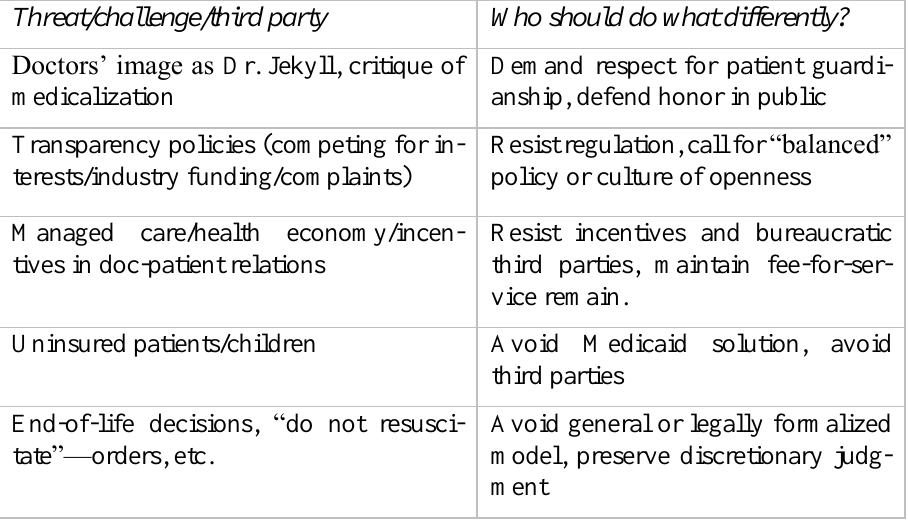
US doctors’ perceived threats to authority and proposed solutions Threat/challenge/third party Who should do what